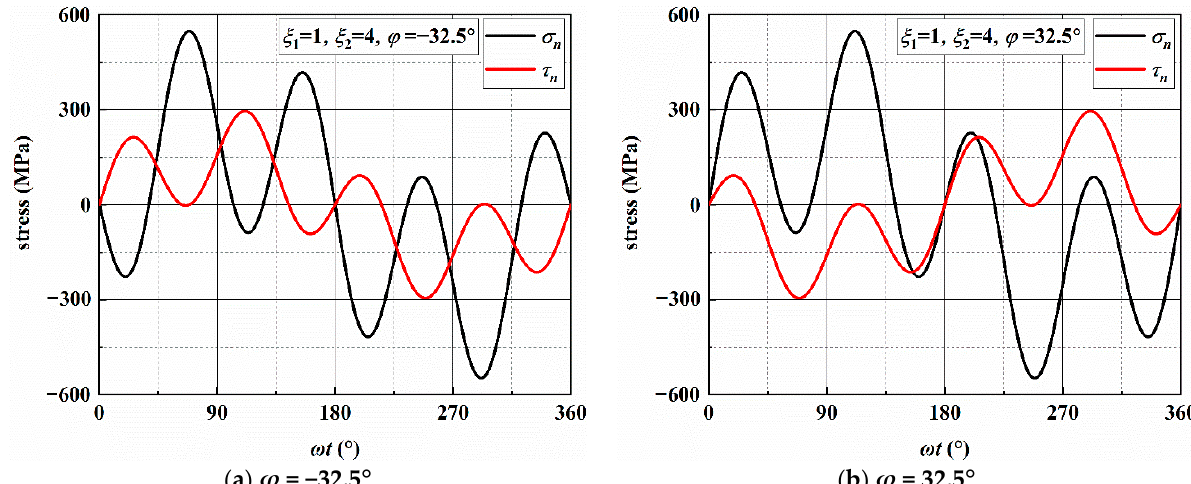
Figure A6. Variation of normal and shear stress on MN plane under AS-4.